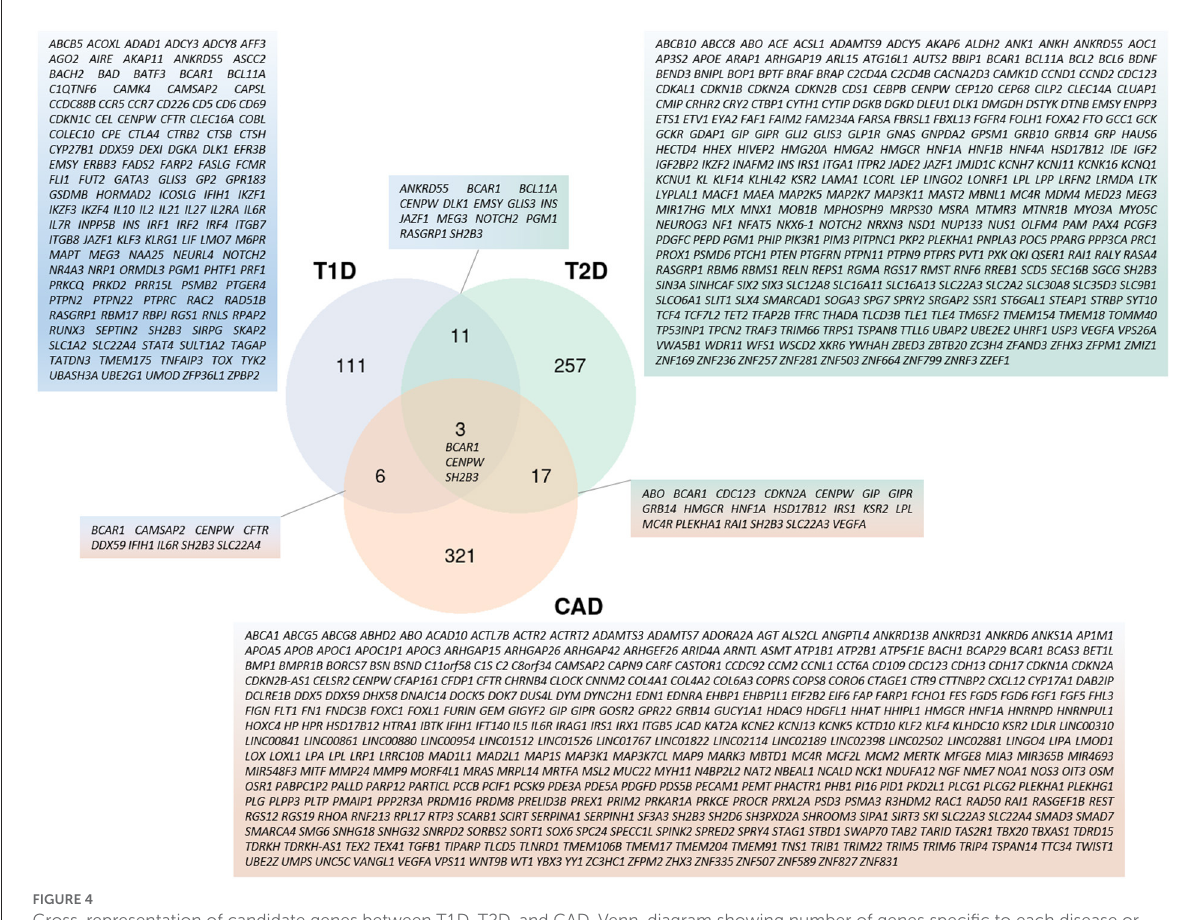
FIGURE4 Cross-representation of candidate genes between T1D, T2D, and CAD. Venn-diagram showing number of genes specific to each disease or shared between 2 and 3 pathologies. Gene symbols for each category are listed. Genes used for this analysis are the same as the ones used